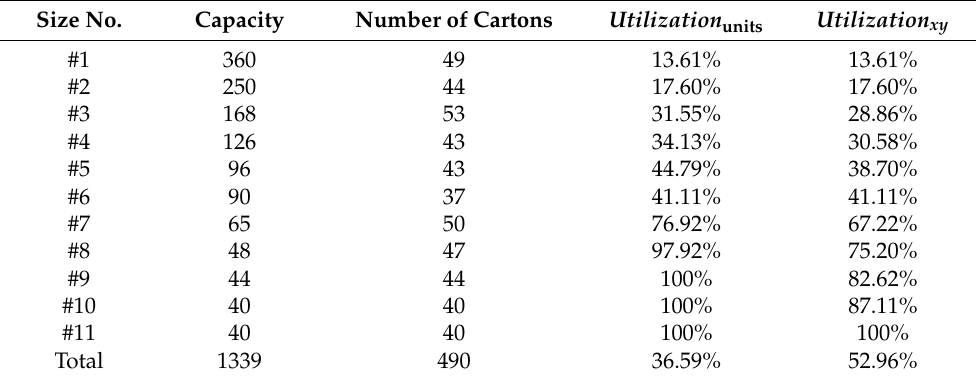
Table 3. The capacity and utilization of each rack in Type B ( Q rack = 11). Size